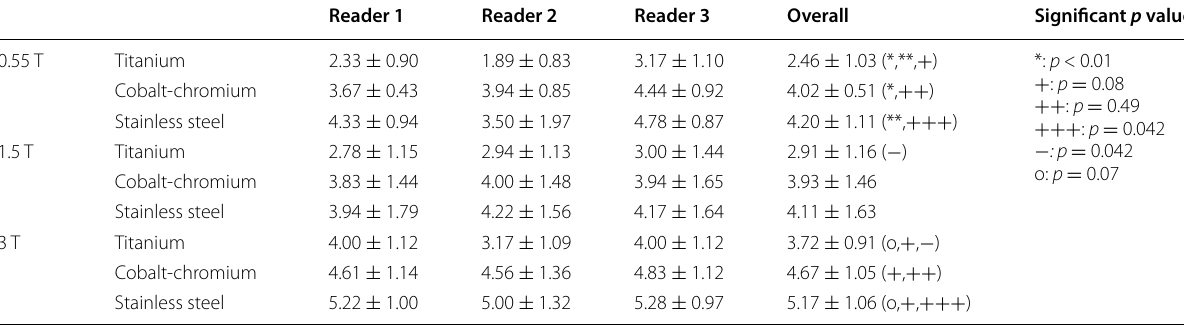
Data are given as mean standard deviation. Pairwise significant differences of the mean score existed between titanium at 0.55 T and cobalt-chromium/stainless ± steel at 0.55 T (*/**), titanium at 0.55 T and titanium at 3 T ( ), titanium at 1.5 T and titanium at 3 T ( + stainless steel at 0.55 T and stainless steel at 3 T ( ), and between Titanium at 3 T and stainless steel at 3 T ( +++